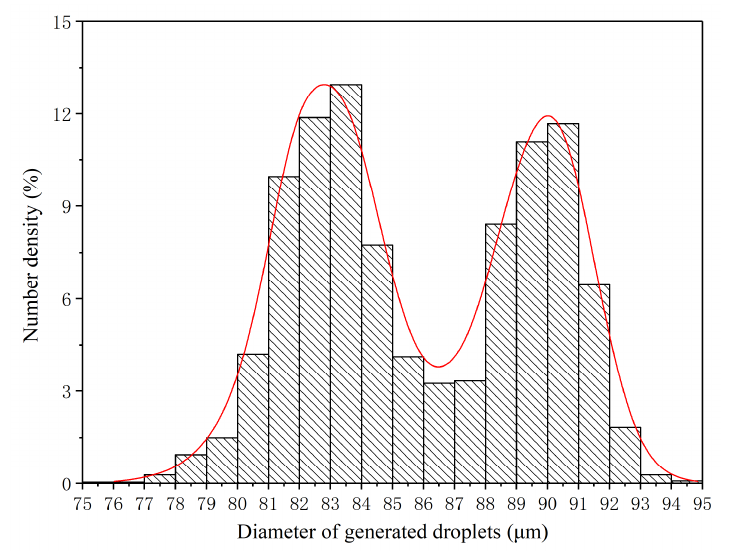
Figure 10. Size distribution of generated monodisperse droplets under OC2 ( q = 30 mL/h, f = 30 kHz).